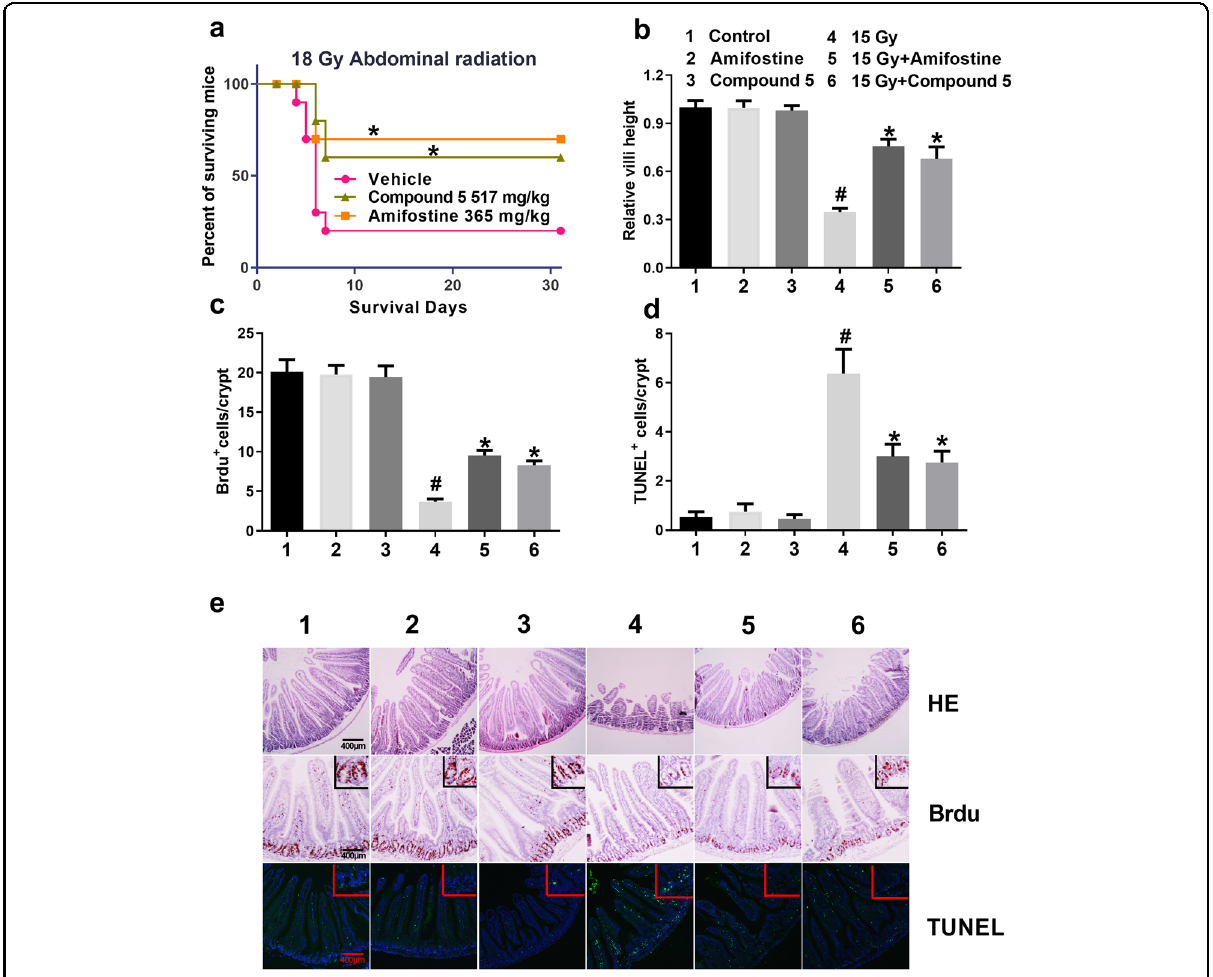
Fig. 6 Compound 5 alleviated radiation-induced gastrointestinal (GI) syndrome. Mice were administered with NS, compound 5 , and amifostine 20 min before 15 Gy and 18 Gy ABI as described in the “ Materials and methods ” section; control mice were sham-irradiated. a Survival rate of mice exposed to 18 Gy ABI; b bar graph shows the relative villi height in mouse intestine; c bar graph shows the percentage of Brdu-positive cells in crypt; d bar graph shows the percentage of apoptotic cells in crypt. e Representation images of HE, Brdu, and Tunnel staining in mouse intestine sections; # p < 0.05 vs Control, * p < 0.05 vs 18 or 15 Gy, N = 8 – 16 in each